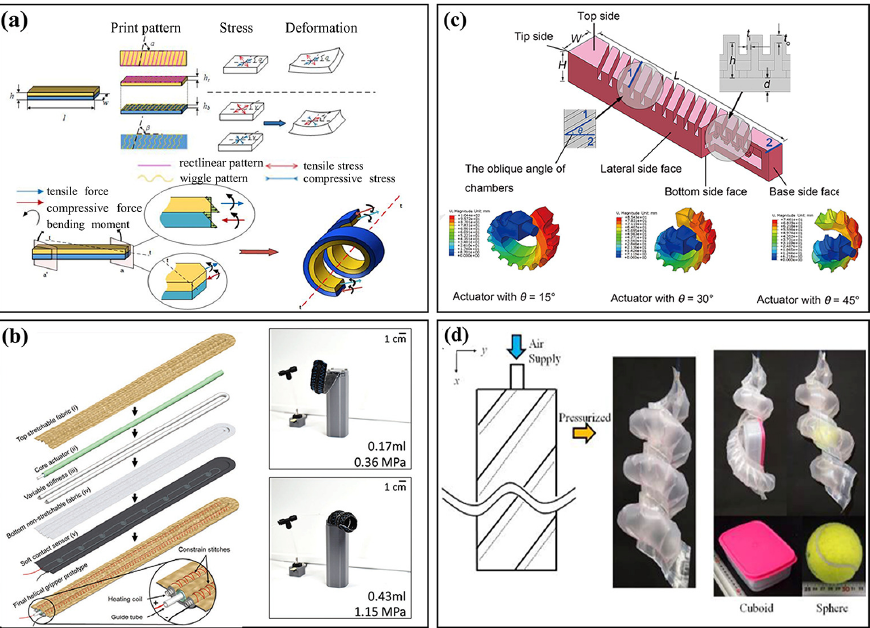
Figure 12. ( a ) Schematic diagram of a bilayer structure under different printing patterns and the principle of deformation [104]. ( b ) Structure of a spiral actuator and spiral deformation posture [105]. ( c ) Structure diagram of an actuator and spiral posture under different pressures [106]. ( d ) Structure diagram of actuator and spiral effect